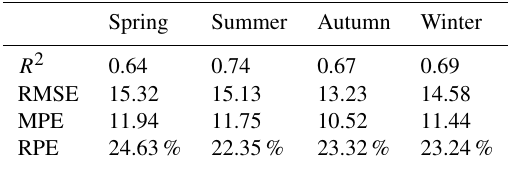
Table 2. The R 2 values, RMSE, MPE, and RPE of RF–GAM in four seasons over the Tibetan Plateau.